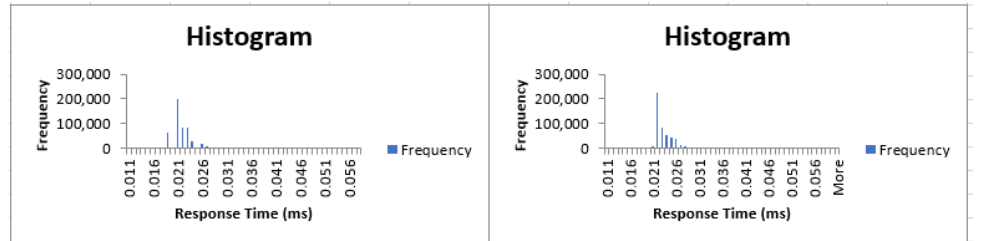
Figure 5. Low data load from Node 1 to Node 2 ( left ) and Node 3 to Node 2 ( right ).